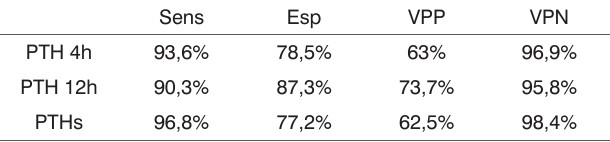
Tabela 1 . Resultados